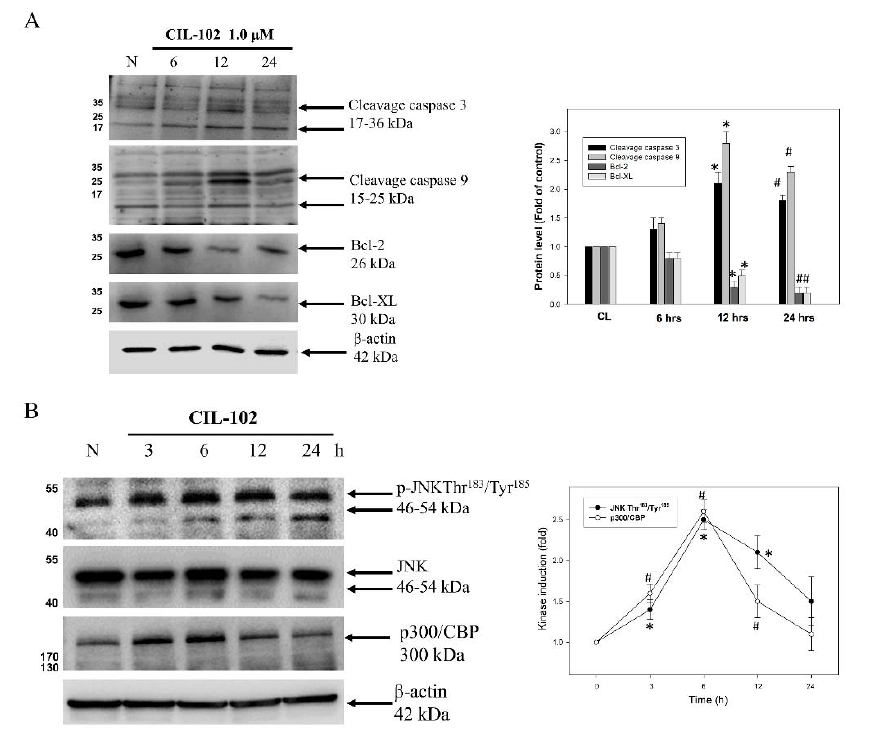
Figure 3. CIL-102 treatment activates the death-related signaling pathways in DLD-1 cells. The protein level of CIL-102 (1 μ M)-treated DLD-1 cell for 0–24 h were detected by Western blot, including cleavage caspase 3, cleavage caspase 9, Bcl-2, and Bcl-XL ( A ) and p-JNK and p300/CBP ( B ). Protein levels were quantified by a densitometric analysis and normalized by a loading control, β -actin. The data are presented as 100% of the control group (means ± SD) from three independent experiments. * p < 0.05, when compared with the untreated control group at 12 h. # p < 0.05, when compared with the untreated control group at 24 h. (B). * p < 0.05, p-JNK when compared with the untreated control group at 12 h. # p < 0.05, p300/CBP when compared with the untreated control group at 24 h.